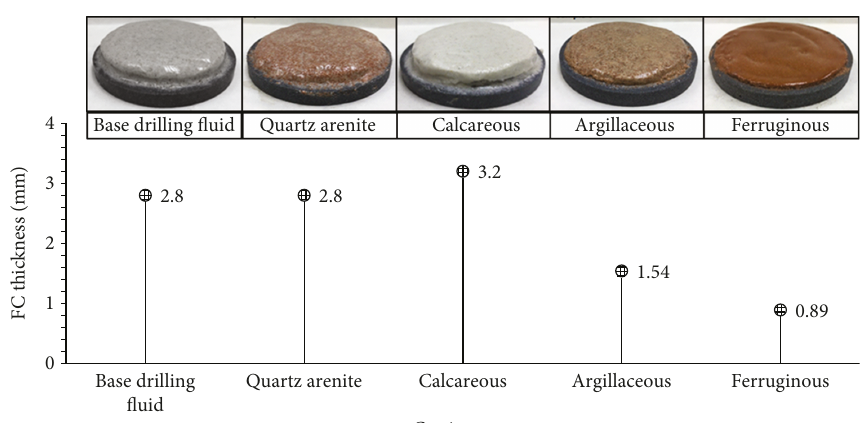
Figure 9: Filter cake thickness of di ff erent cutting